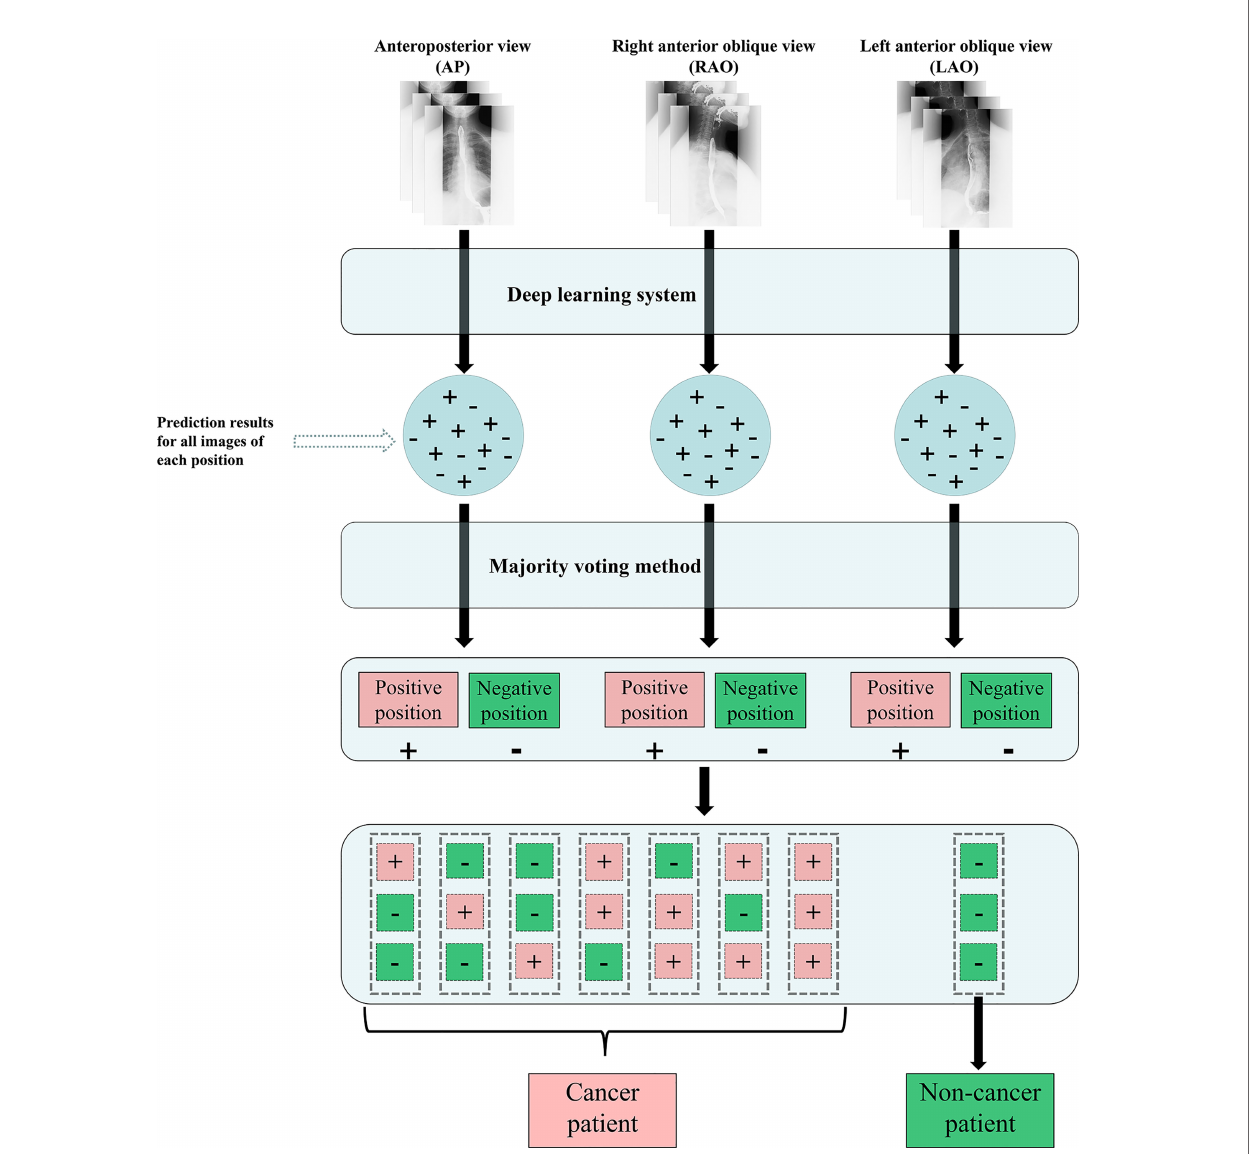
FIGURE 2 | Flow chart of the DLS approach for esophagram-based esophageal cancer diagnosis. (+) esophageal cancer; (-) no esophageal cancer; DLS, deep learning